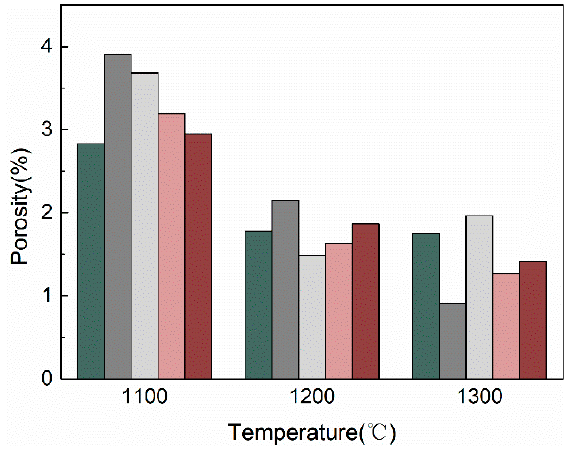
Figure 6. Porosity of these samples when sintered at various temperatures. Table 3. Performance of TC4 at different temperatures. Conditions